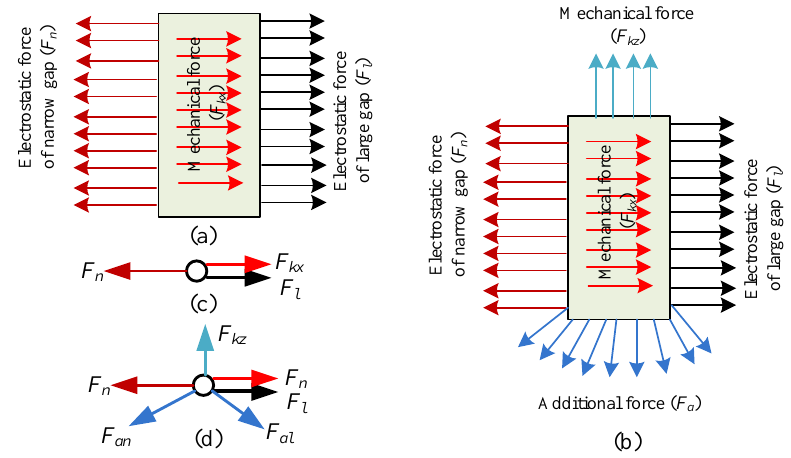
Figure 5. The force acting on finger: ( a ) initial state; ( b ) polarization state; ( c ) simplification of the initial state; and ( d ) simplification of the polarization state.